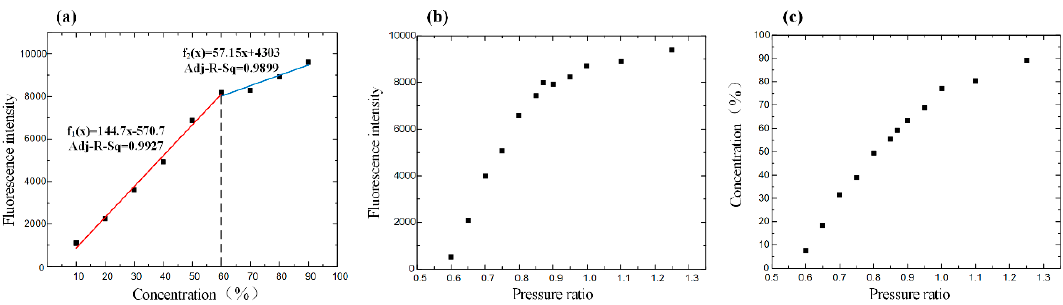
Figure 4. ( a ) Driving the standard fluorescence solution in the channel of the chip to obtain the relationship between fluorescence intensity and concentration. ( b ) Adjusting the pressure ratio to drive the solutions of rhodamine B and acetonitrile mixing in the channel and observe the fluorescence intensity of the mixture solution under the scanning electron microscope. The curve shows the relationship between fluorescence intensity and pressure ratio. ( c ) The relationship between the concentration and pressure